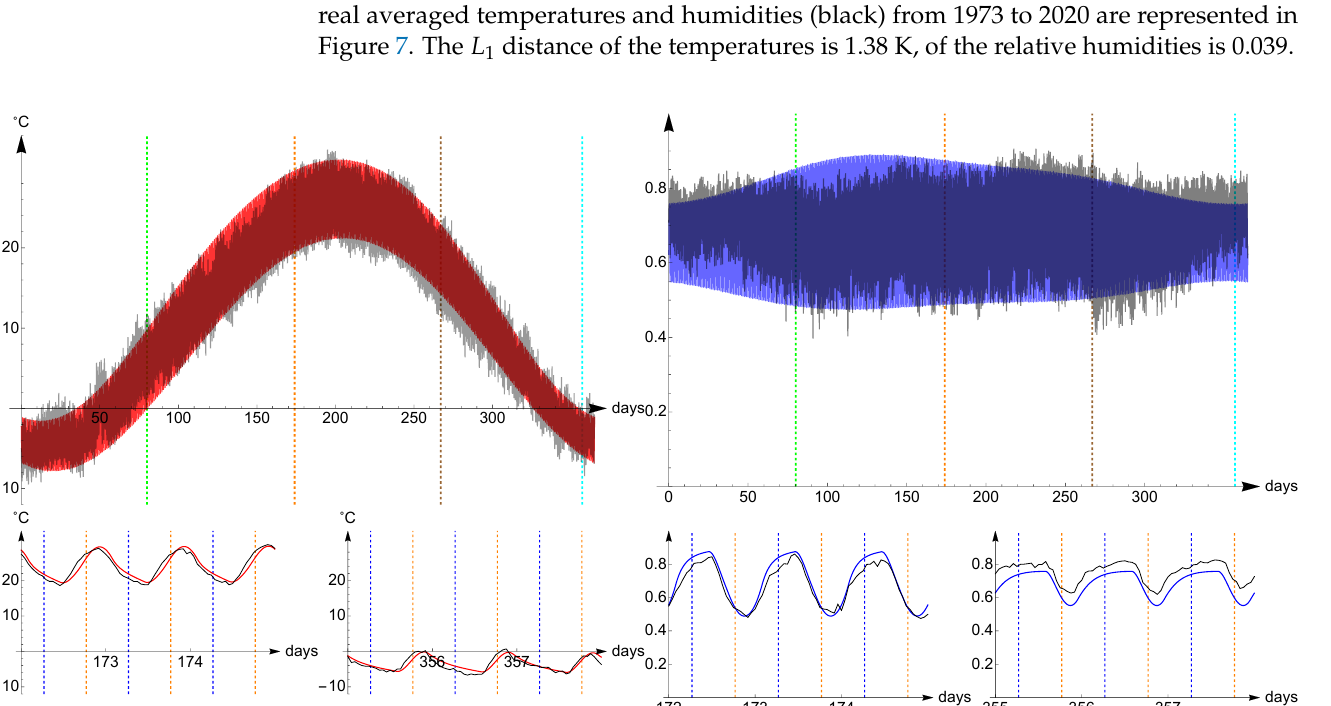
Figure 7. Mean and computed temperature ( left ) and relative humidity ( right ) in Lincoln during the year ( top ) and on solstices and equinoxes ( bottom ). In black the average temperatures and humidities, in red simulated temperatures, in blue simulated humidity, the grid lines represent solstices, equinoxes, noons and